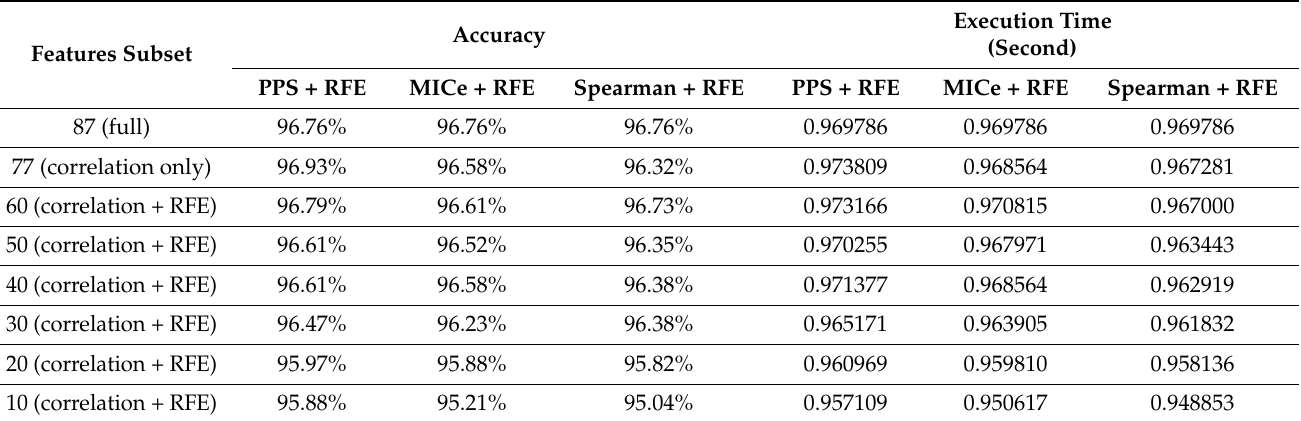
Table 16. Feature subset accuracy using Spearman on Dataset